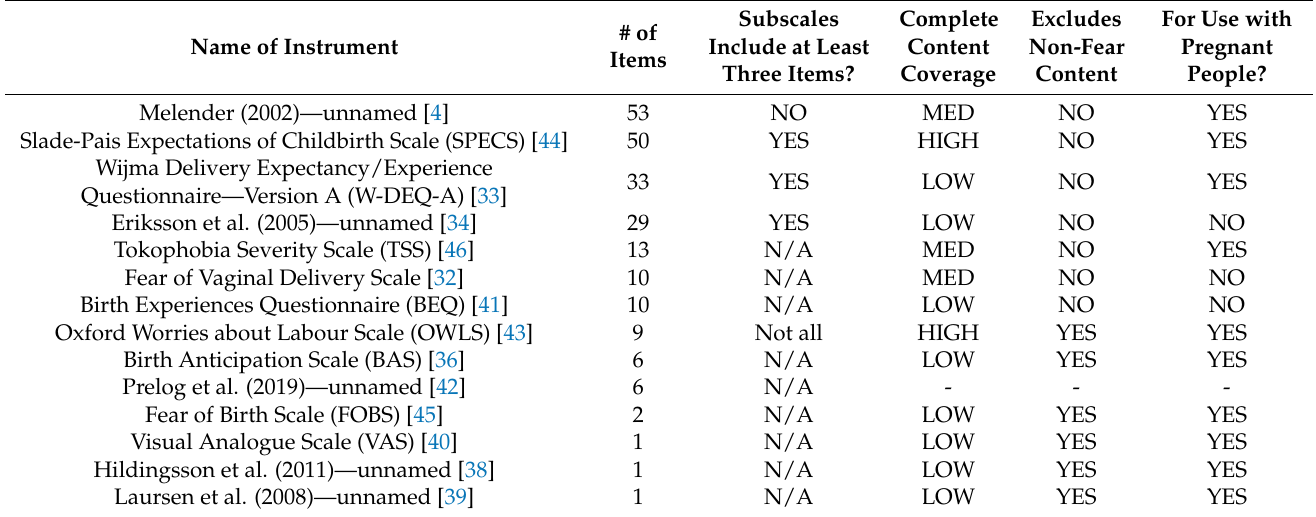
Table 1. Measurements of fear of